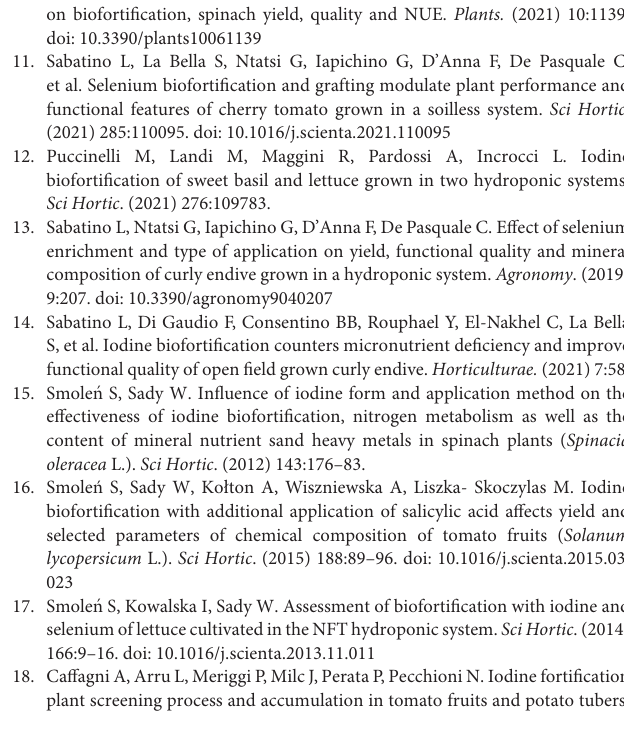
Supplementary Figure 1 | Graphical abstract showing the different phases of biofortified food production, administration and results